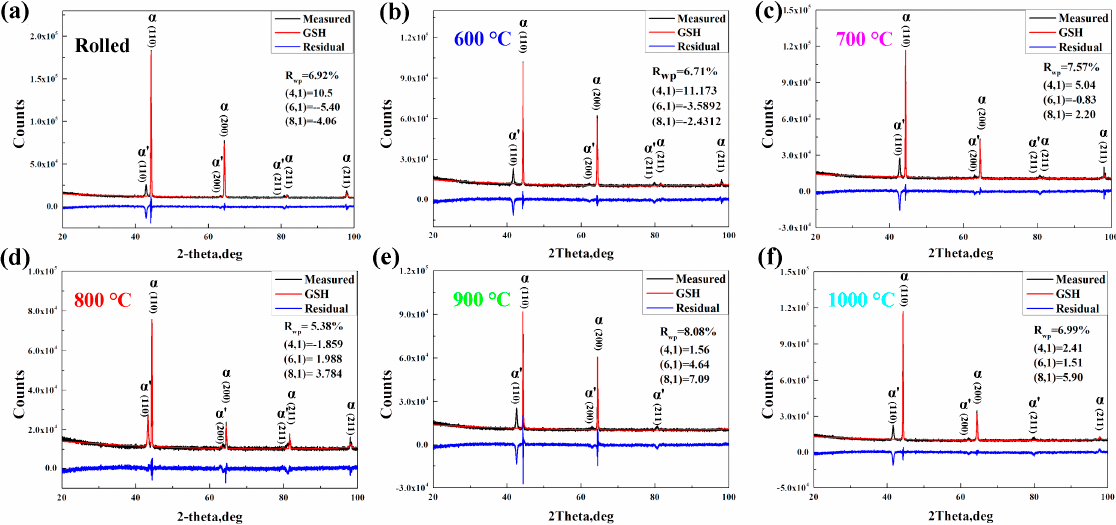
Figure 3. The agreement between measured and calculated XRD profile for the rolled and annealed Fe-25Cr-5Al-RE wire rods following Rietveld refinement with generalized spherical harmonics description (GSH) for preferred orientation correction. ( a ): rolled; ( b ): 600 ◦ C; ( c ): 700 ◦ C; ( d ): 800 ◦ C; ( e ): 900 ◦ C; ( f ): 1000 ◦ C.